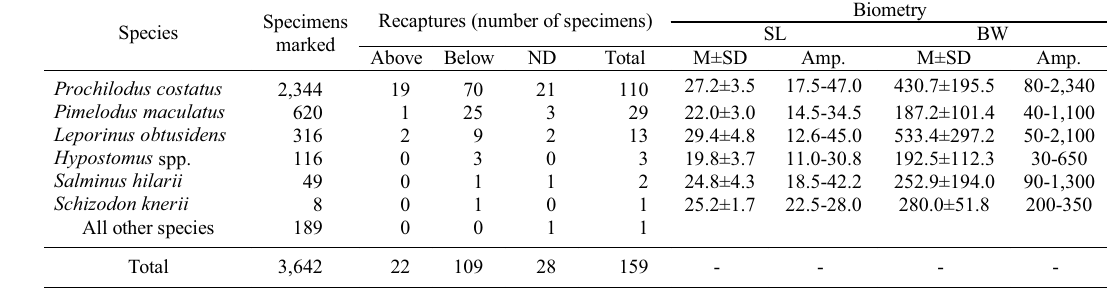
Table 1 . Data on fish marked and recaptured in rio Paraopeba from 1997 to 2001. ND = not determined; M = mean; SD = standard deviation; Amp. =